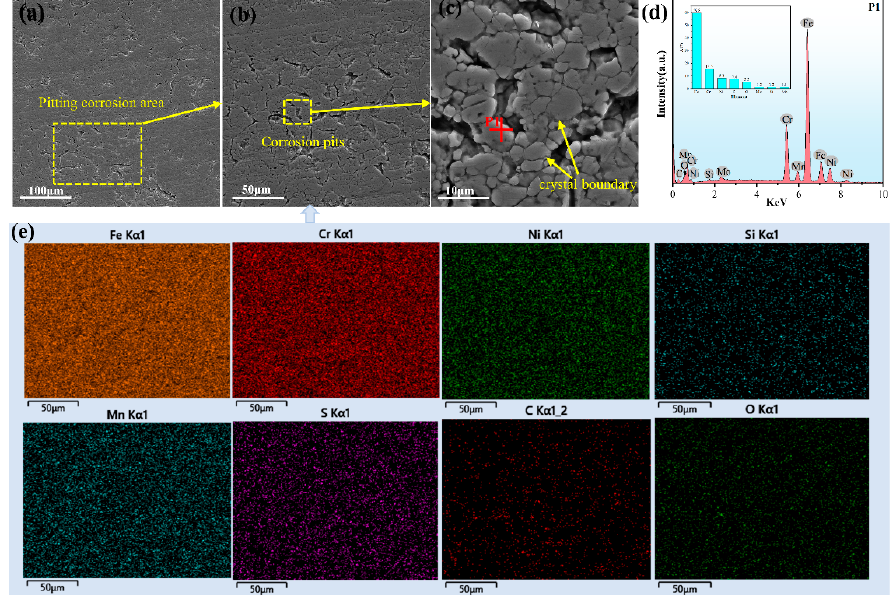
Figure 8. SEM and EDS point sweep of AISI 316L stainless steel after corrosion. ( a – c ) SEM micrograph of AISI 316L after corrosion; ( d ) EDS analysis of P1 point; ( e ) EDS Analysis of Element Distribution on AISI 316L Surface.